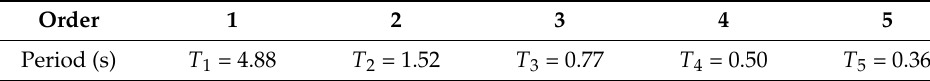
Figure 1. Elevation and plan views of the 48-story building. Table 2. First five periods of the mega-scale frame Table 1. Section geometries and materials of structural components (units: m).